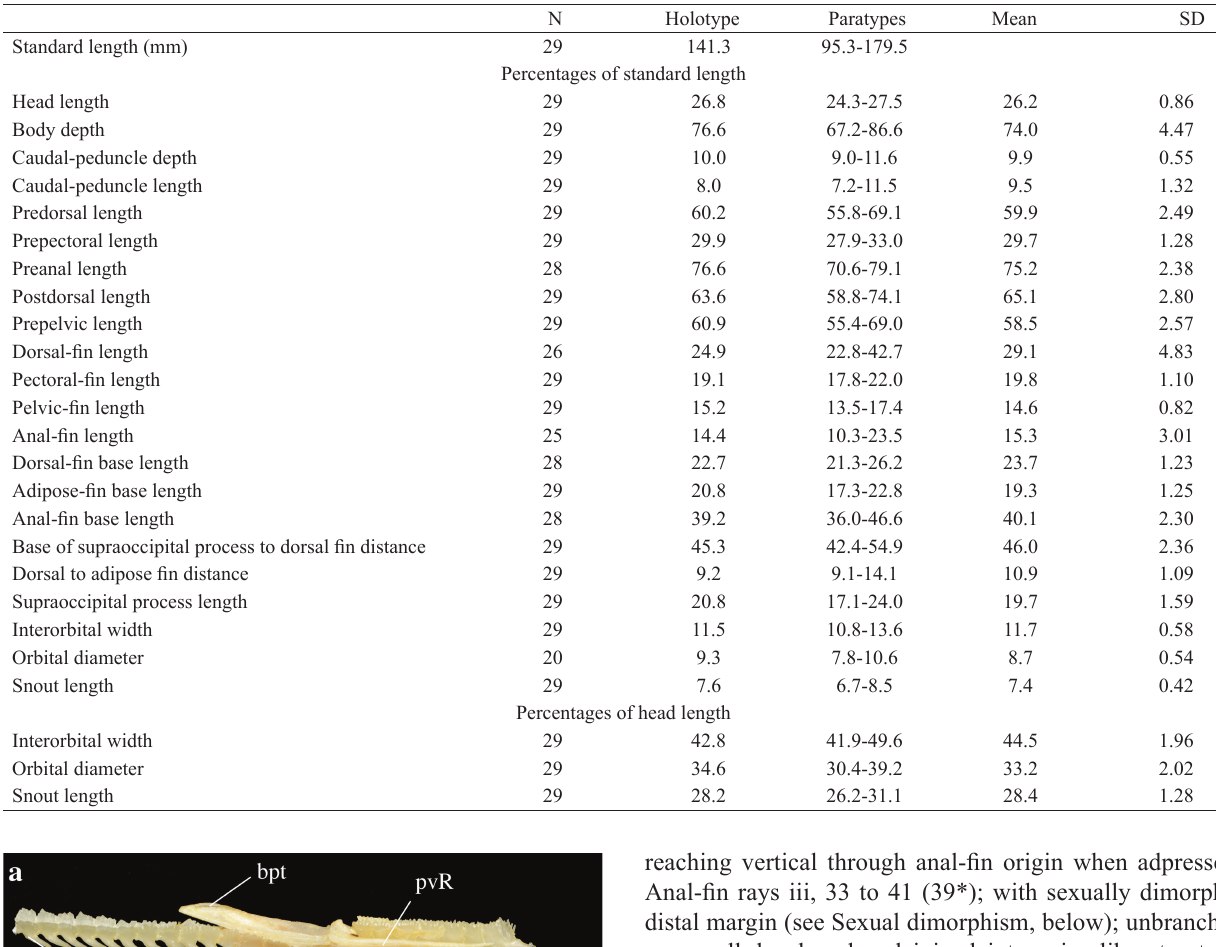
Table 1. Morphometric data of Metynnis melanogrammus , new species. N = Number of specimens, and SD = standard deviation. N